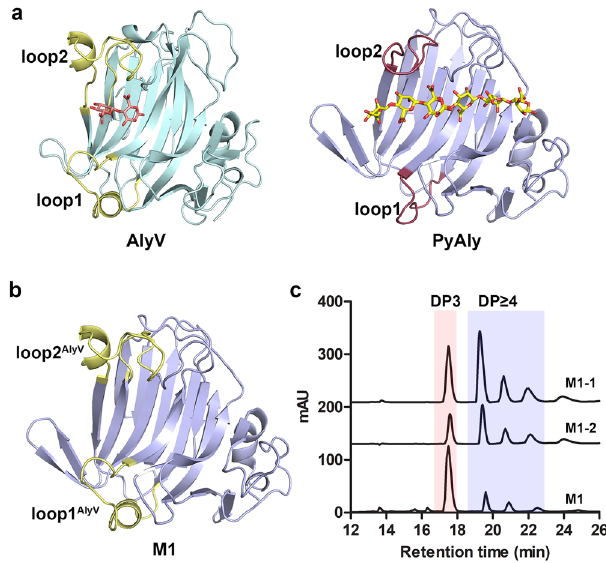
Fig. 5 Two loops in the “ - ” section were demonstrated to determine product distribution. a The positions of two loops (loop1 and loop2) from AlyV and PyAly. loop1 AlyV : Pro117-Ala134; loop2 AlyV : Val183-Leu210; loop1 PyAly : Thr108-Lys117; loop2 PyAly : Arg159-Phe170. b Diagram of the constructed chimeric PyAly M1, containing loop1 AlyV and loop2 AlyV . c Product distributions of M1, M1-1, and